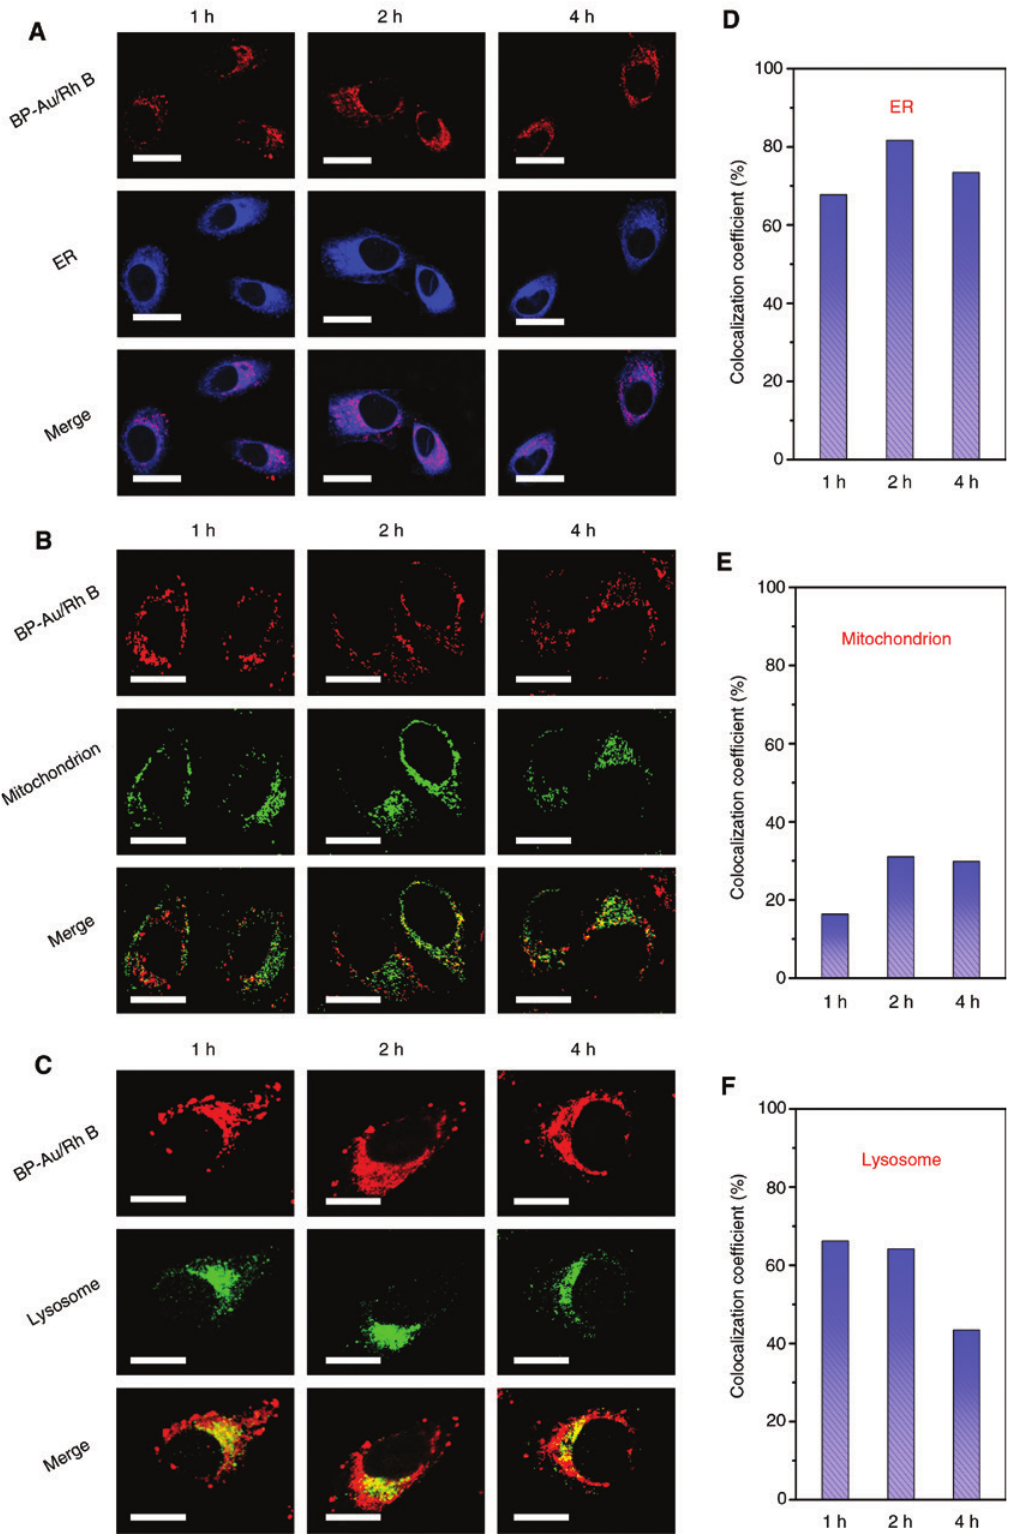
Figure 5: Fluorescence co-localization analysis of BP-Au NSs with the (A) ER, (B) mitochondria and (C) lysosome at different time points. Scale bar: 20 μ m. (D–F) Colocalization coefficients between nanohybrids and different